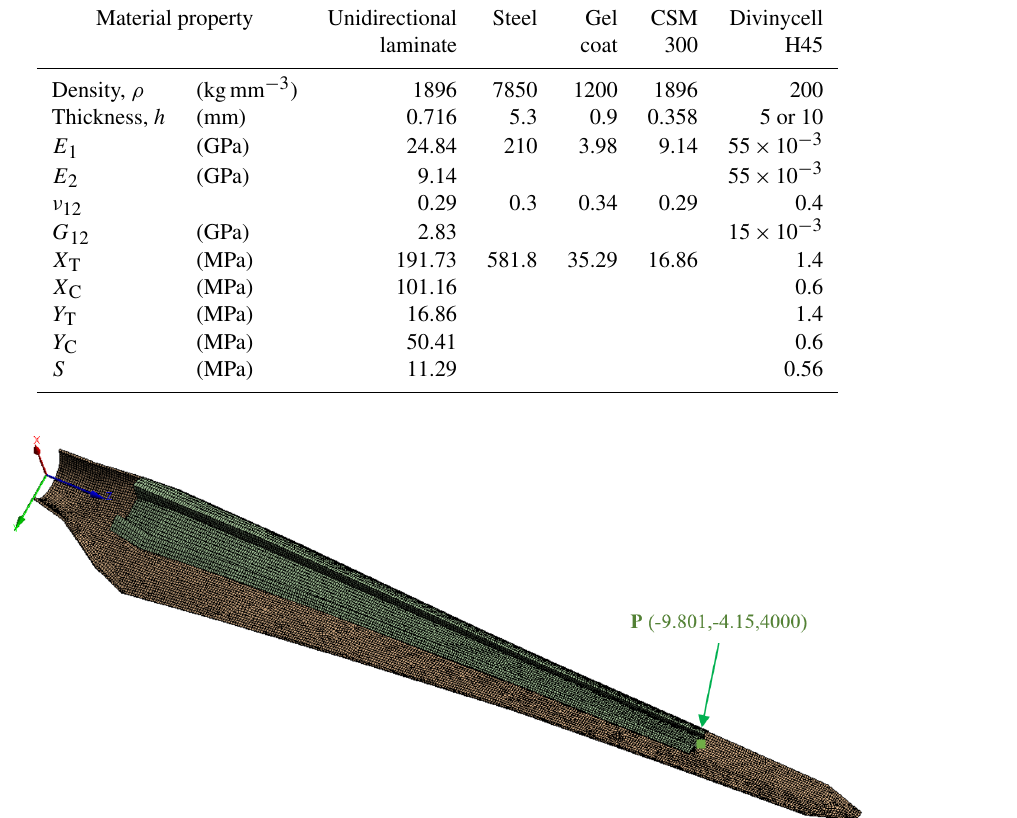
Table 2. Material properties and design allowables of RÜZGEM blade for static analysis.